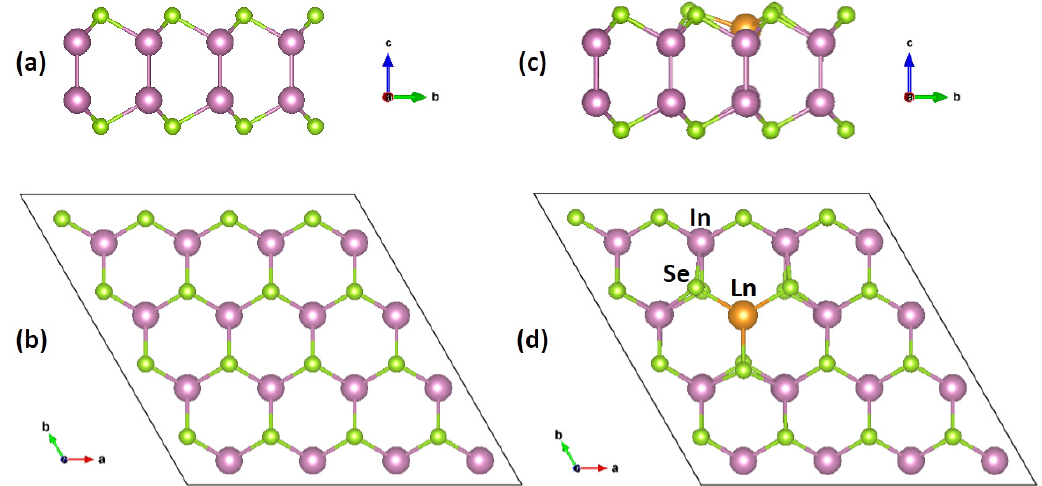
Figure 1. ( a – d ) Side view ( a , c ) and top view ( b , d ) of the pristine 4 × 4 × 1 InSe monolayer supercell ( a , b ) and the Ln-doped system ( c , d ). Ln stands for the lanthanide dopant atom (Ln = Ce, Nd, Eu, Tm). The In, Se, and Ln atoms are labeled in purple, green and yellow, respectively.